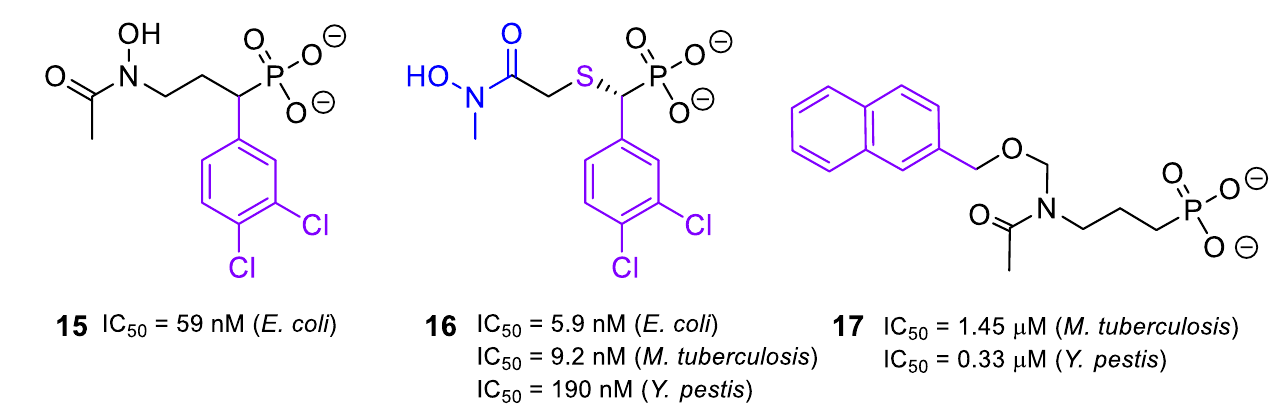
Figure 2. Representative inhibitors of DXR.